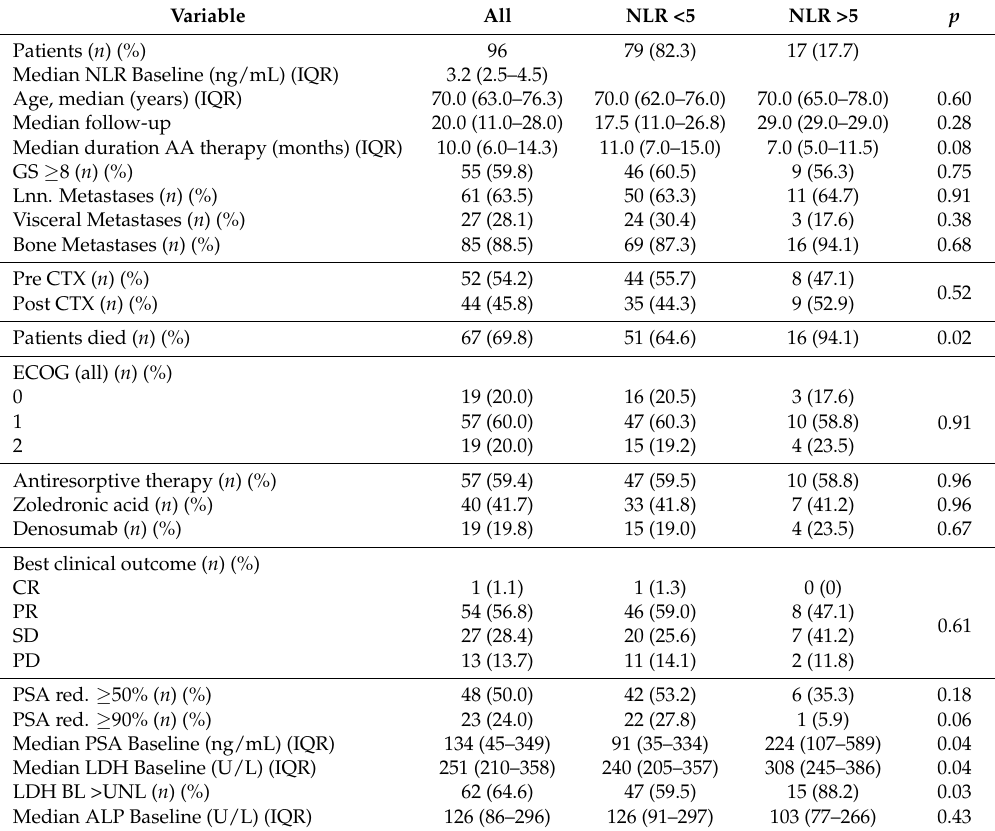
Table 1. Characteristics of patients with metastatic castration-resistant prostate cancer (mCRPC) on Abiraterone with a neutrophil-to-lymphocyte-ratio (NLR) <5 and >5.